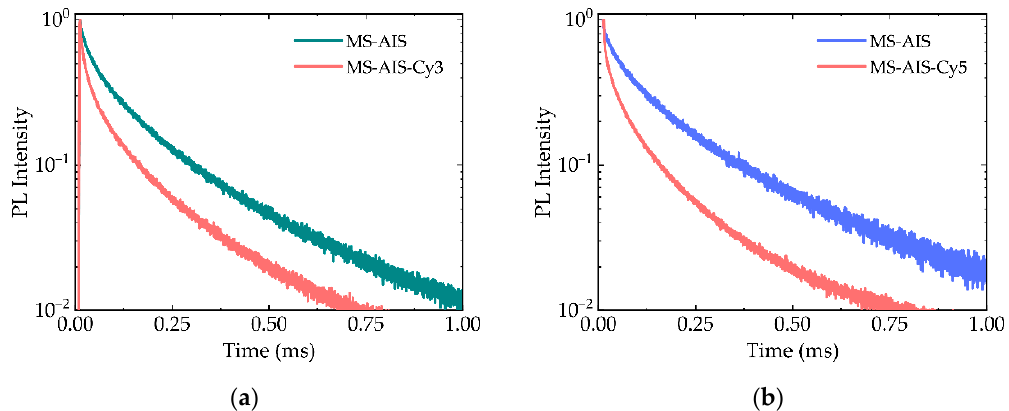
Figure 6. PL decay curves of ( a ) PMS-AIS (green) and PMS-AIS-Cy3 L2 (red) registered at the 580 nm and ( b ) PMS-AIS (blue) and PMS-AIS-Cy5 L2 (red) recorded at the 665 nm.